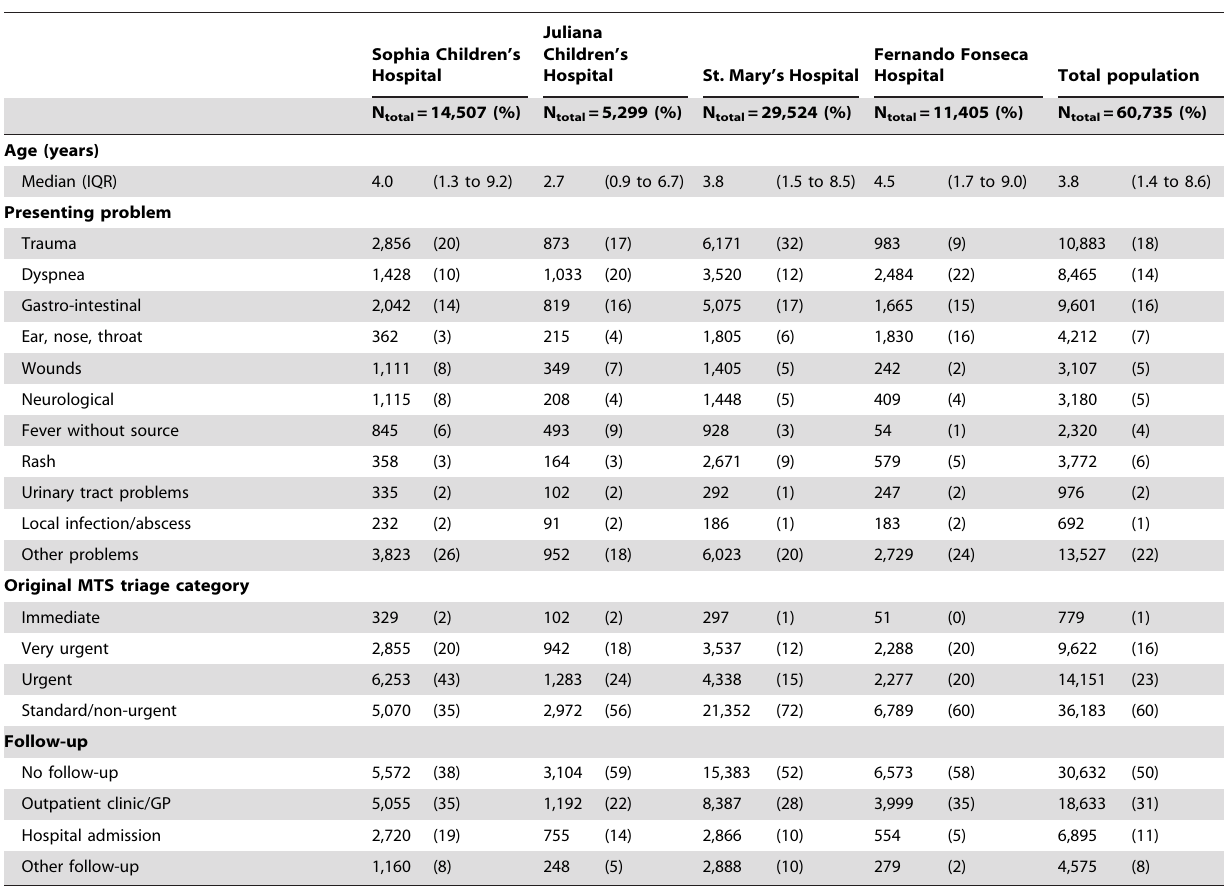
Table 2. Patients’ characteristics per